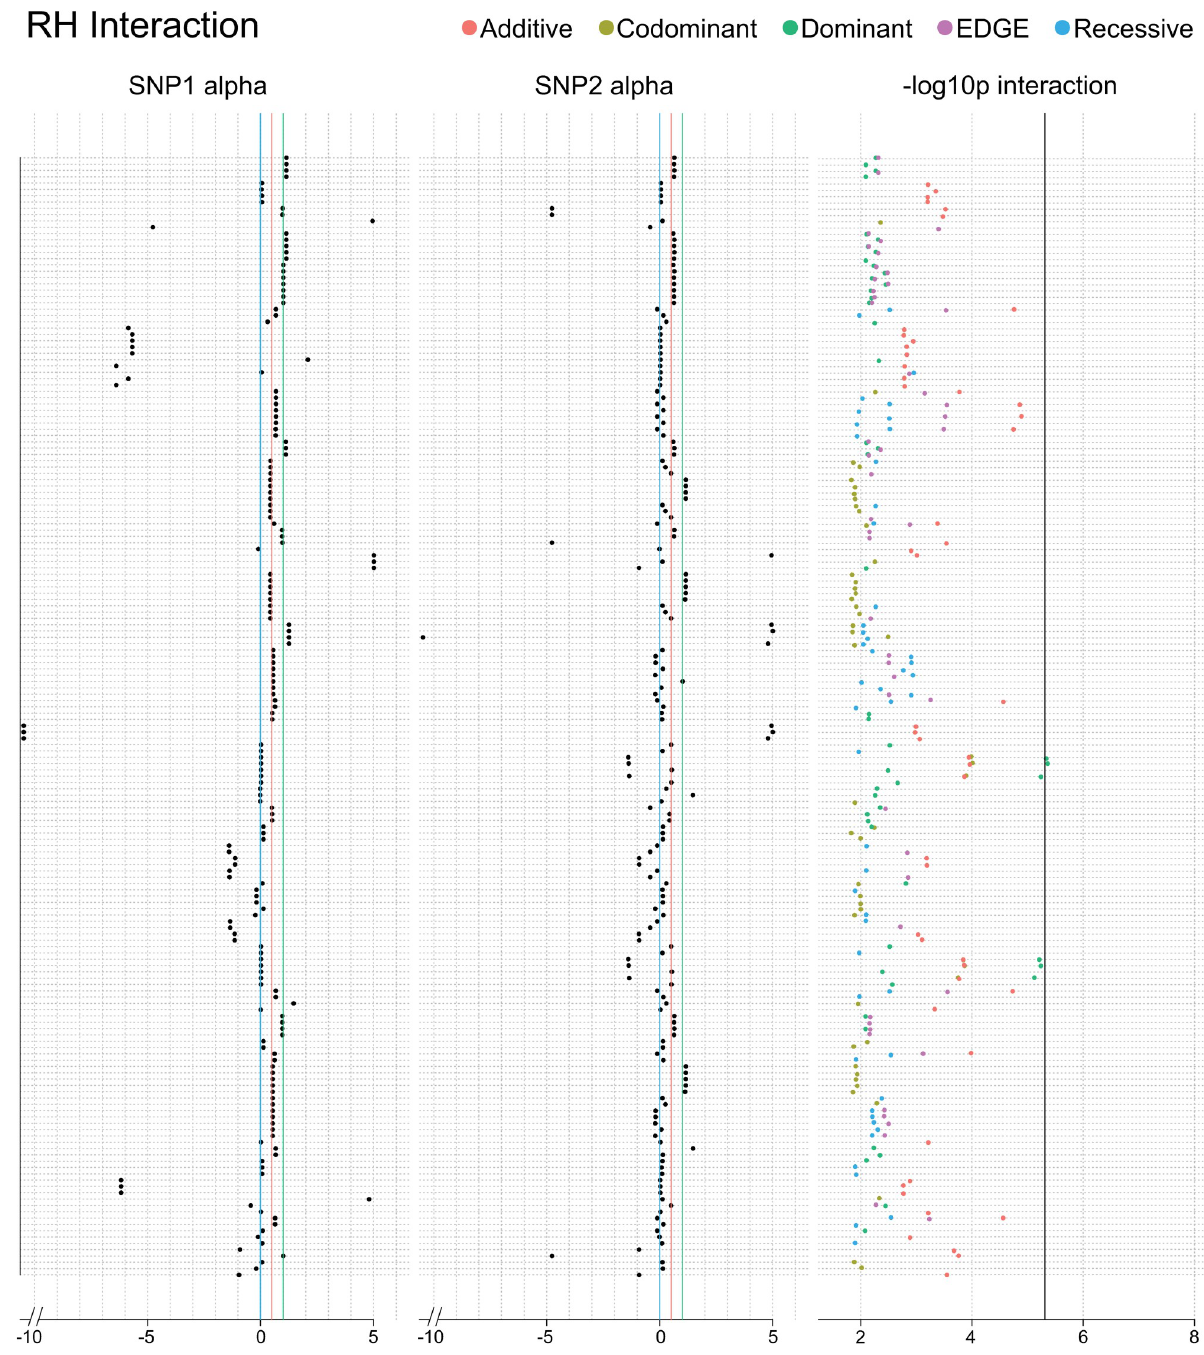
Fig 12. Interaction plot of the top results from the main effect filtered SNP-SNP interaction analysis for resistant hypertension. The top 50 SNPs from the multi-encoding resistant hypertension GWAS were considered for a pairwise SNP-SNP interaction analysis using additive (red), dominant (green), recessive (blue), codominant (yellow) and EDGE (purple) encoding methods. Track one displays the EDGE-derived heterozygous alpha value of SNP 1, track 2 displays the alpha value for SNP 2, and track 3 displays the–log10 of the unadjusted LRT p-value of each SNP-SNP interaction model. Vertical blue lines denote a 0 alpha value (indicative of recessive genetic model), vertical red lines denote a 0.5 alpha value (indicative of additive genetic model), vertical green lines denote an alpha value of 1 (indicative of dominant genetic model). Note that some of the SNPs demonstrated alpha values outside the 0–1 range, indicative of under-recessive ( α < 0) and over-dominant ( α > 1) genetic models. The vertical black line denotes the Bonferroni significance threshold for this analysis (10,296 SNP-SNP models